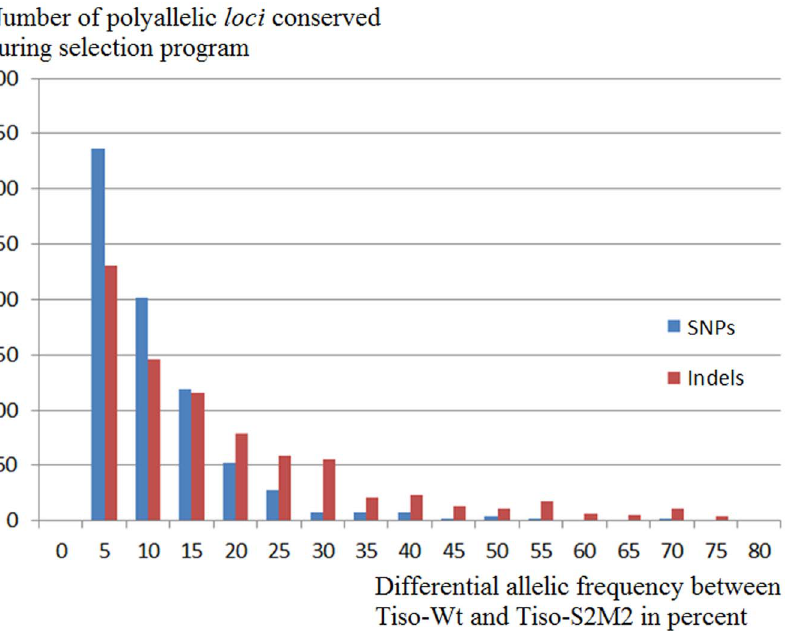
Figure 4. Distribution of differential allelic frequency between Tiso-Wt and Tiso-S2M2. This histogram represents the number of polymorph loci (SNP and indel) following their conservation rate through the selection program. Conservation rate defined as percent represents the differential allelic frequency between Tiso-Wt and Tiso-S2M2.